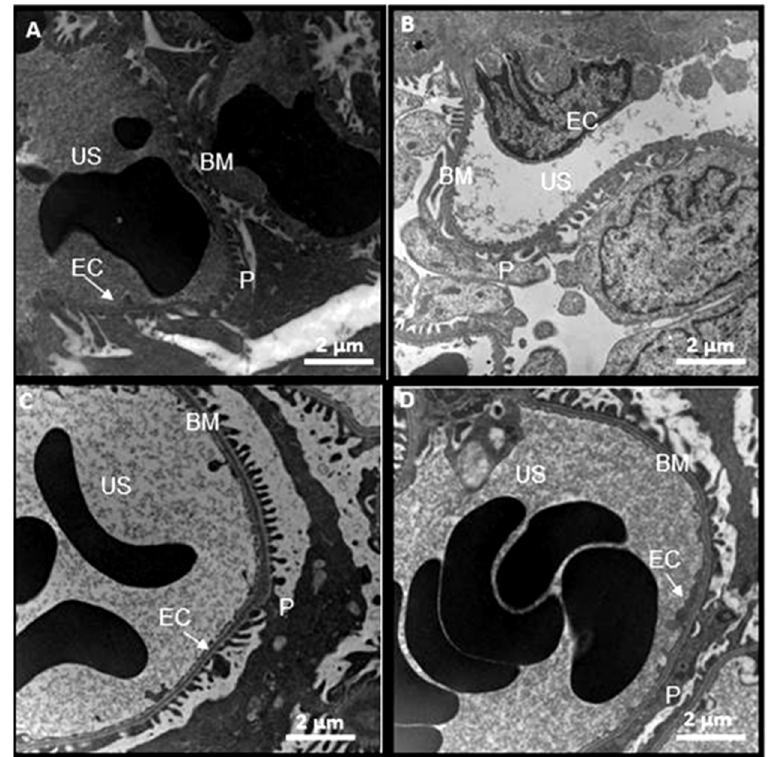
Figure 12. Electron photomicrographs representative of the capillary loops and the ultrastructure of rat glomeruli from the experimental groups at 12,000 × . The collapsing glomerulopathy group showed podocyte foot processes and a display of abnormal shapes and obliteration in comparison to the other groups. ( A ) Control, ( B ) kidneys from rats injected with saline solution, ( C ) kidneys from rats that received serum from healthy subjects and ( D ) kidneys from rats that received serum from patients having collapsing glomerulopathy. Abbreviations: EC = endothelial cell, p = podocytes, US = urinary space, BM = basal